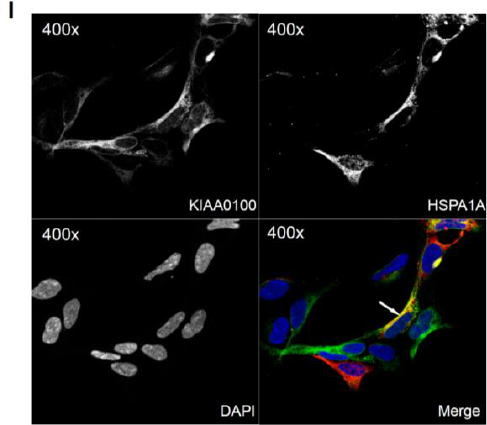
Figure 6. Over-expressing recombinant KIAA0100 protein in HEK293 cells. KIAA0100 over-expressing cell line HEK293/pKIA was established by transfecting KIAA0100 recombinant plasmid to HEK293 cells: ( A ) cell morphology comparison between HEK293 and HEK293/pKIA. 24 and 48 h after seeding same number of cells to the culture plate; ( B ) Western blot confirmed over-expression of the KIAA0100 recombinant protein in HEK293/pKIA cells compared to the parent HEK293 cells; ( C ) immunofluorescence detection of the recombinant KIAA0100 and microtubule network (TUBA) in HEK293/pKIA cells. Cells with white arrow were not expressing recombinant KIAA0100, it served as control for the recombinant KIAA0100 staining; ( D ) recombinant KIAA0100 was captured by anti-FLAG antibody from cell lysate. The captured proteins were separated on 4–12% SDS-PAGE and stained with coomassie blue. Six gel slices were excised and labeled S1 to S6 for mass spectrometry analysis; ( E ) top protein calls from mass spectrometry analysis that match the molecular weight according to the gel slice positions; ( F ) Western blot to confirm the protein identified in the mass spectrometry analysis, IP with anti-FLAG tag antibody and anti-HSPA1A antibody compared to the corresponding controls with anti-DIG antibody as well as empty beads are presented; ( G ) immunofluorescence of recombinant KIAA0100 in HEK293/pKIA cells in a higher magnification, arrow point to the thread-like structure that both appears in the KIAA0100 staining and the TUBA staining; ( H ) immunofluorescence detection recombinant KIAA0100 and F-actin filaments detected by Phalloidin in HEK293/pKIA cells; ( I ) immunofluorescence of HEK293/pKIA cells stained with KIAA0100 and HSPA1A (arrow point to the potential co-localization spot). In all immunofluorescence images above, KIAA0100 showed in green; other co-stained targets showed in red color.